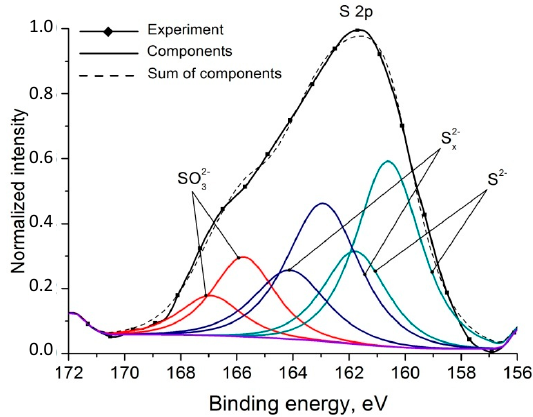
Figure 3. XPS S 2p 3/2-1/2 . The Kvartsevaya Sopka deposit. Sample P-5707. Curve legends are presented in Figure 2.